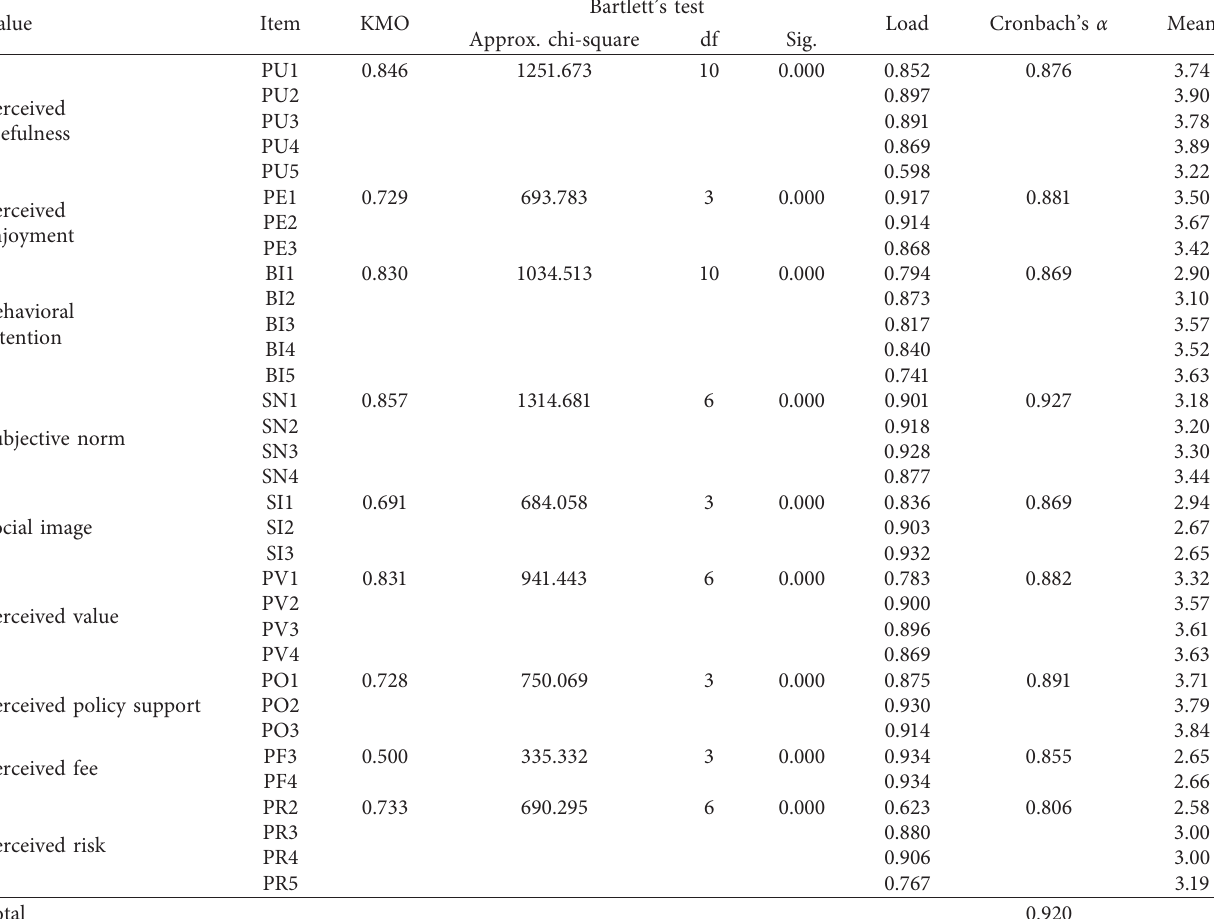
Table 4: Reliability and validity test.